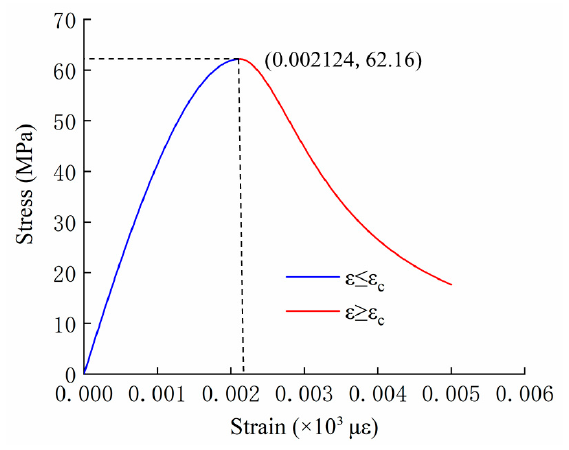
Figure 1. Constitutive relationship of C-1 concrete under axial compression.